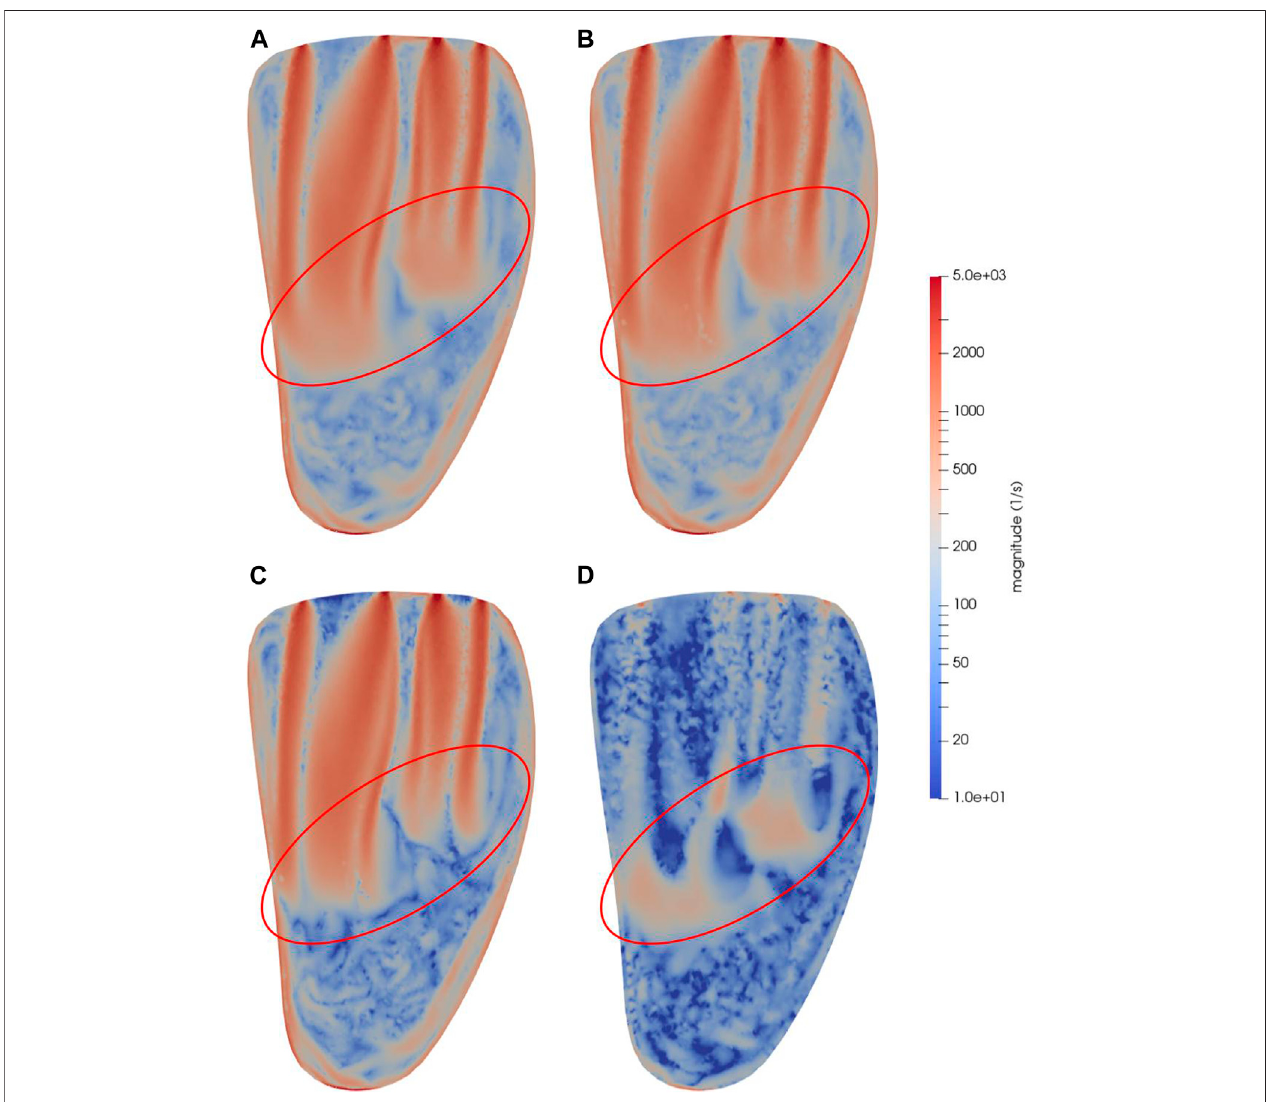
FIGURE 8 | Snapshots of (A) von Mises-like SSS, (B) shear and strain summed, (C) shear and (D) strain at time t = 0.45 s in a bicommissural vertical cut through theleftventricle.ThissimulationwasdonewithaMVCplacedat s · l fromthecenterofthecoaptationline,with l beingthelongaxisintheMVmodel,andthepositionscale factor s = 0.2. The red ellipses indicate signi fi cant areas of particularly high strain, to highlight the difference between SSS and shear computed using the triple decomposition. The velocity and pressure at this time are shown in Figures 3C , 4C respectively.